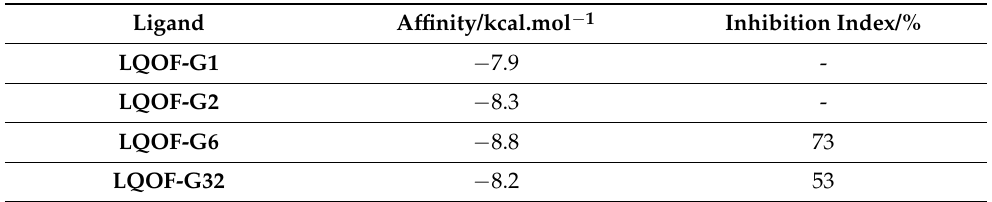
Figure 8. Results of the molecular docking investigation of LQOF-G1 and interactions representations in ( a ) 3D perspective, ( b ) 2D perspective, and of LQOF-G6 ( c ) 3D representation of the interactions and ( d ) 2D representation. Cyan = carbon, red = oxygen, purple = nitrogen, yellow = sulfur, and white = hydrogen. Table 4. Binding affinity of the “best” mode of the ligand with the active site of 6P4E enzyme and experimental inhibition